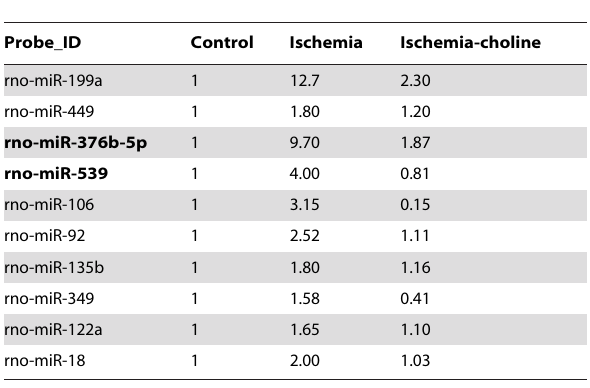
Male Wistar rats were divided into control, ischemia and choline chloride (choline, agonist of M 3 -mAChR) groups. Myocardial ischemia model was induced for 24 h. Choline (10 mg/kg, i.v.) was administrated 10 min before occlusion. After 24 h ischemia, ventricular tissues were dissected for miRNA microarray analysis. MiRNAs levels were calculated based on the normalization to control group (set as